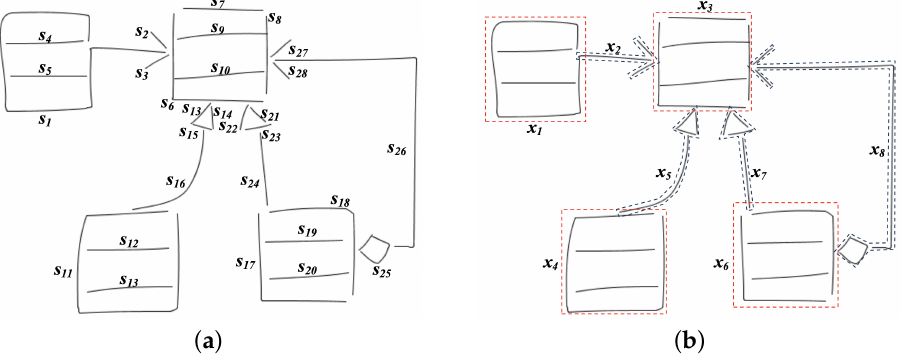
Figure 4. A sketched class diagram ( a ) and the shapes forming it ( b